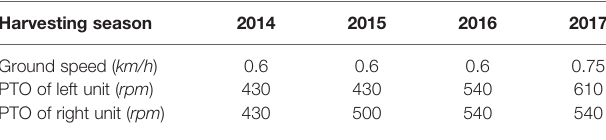
TABLE 1 | Operation parameters of Side-Row Continuous Canopy Shaking